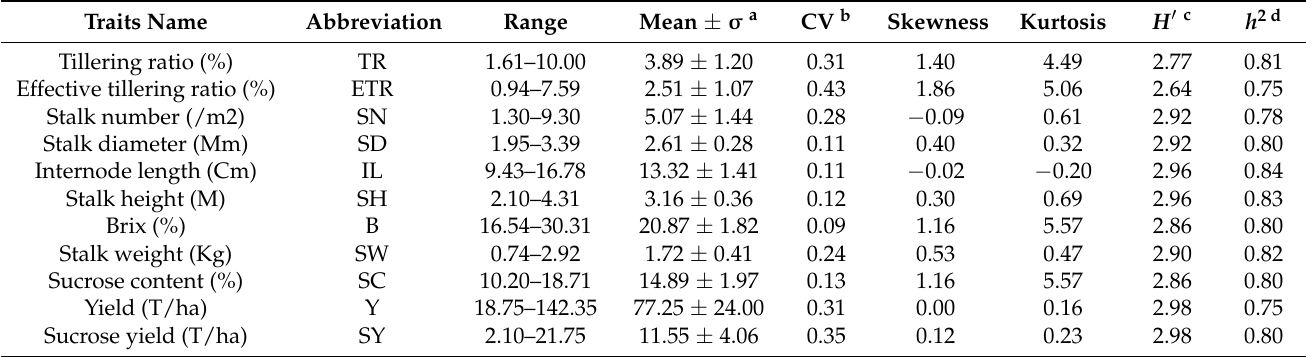
Table 1. Characteristics and diversity analysis of sugarcane hybrid F 1